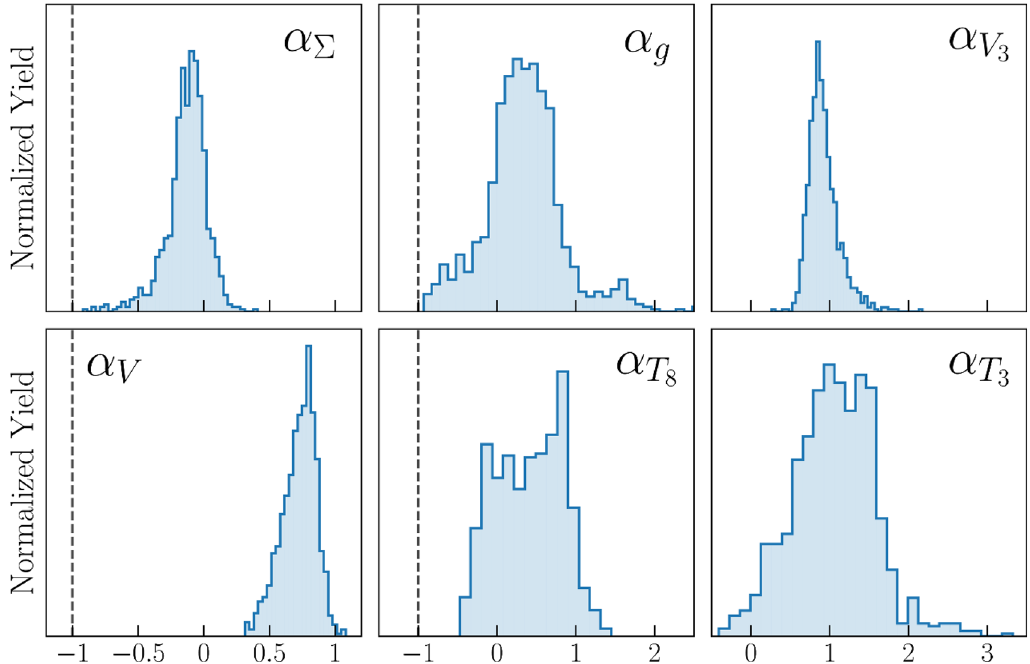
Figure 3 . The probability distribution associated to the (cid:12)tted small- x preprocessing exponents (cid:11) f computed with the N rep = 1000 replicas of the nNNPDF2.0 NLO set. The ranges for which these exponents are allowed to vary, eq. (3.16), are indicated by horizontal dashed lines. Note the di(cid:11)erence in the x -axis range values for each